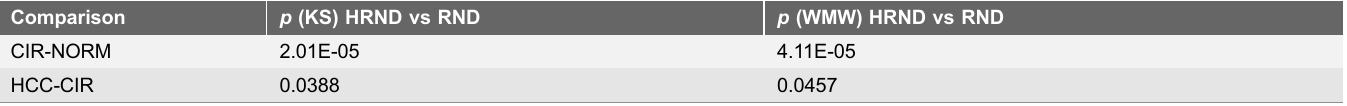
Table 4. Random subnetworks in network proximity to HCV targets are more enriched in differentially expressed genes than random subnetworks.